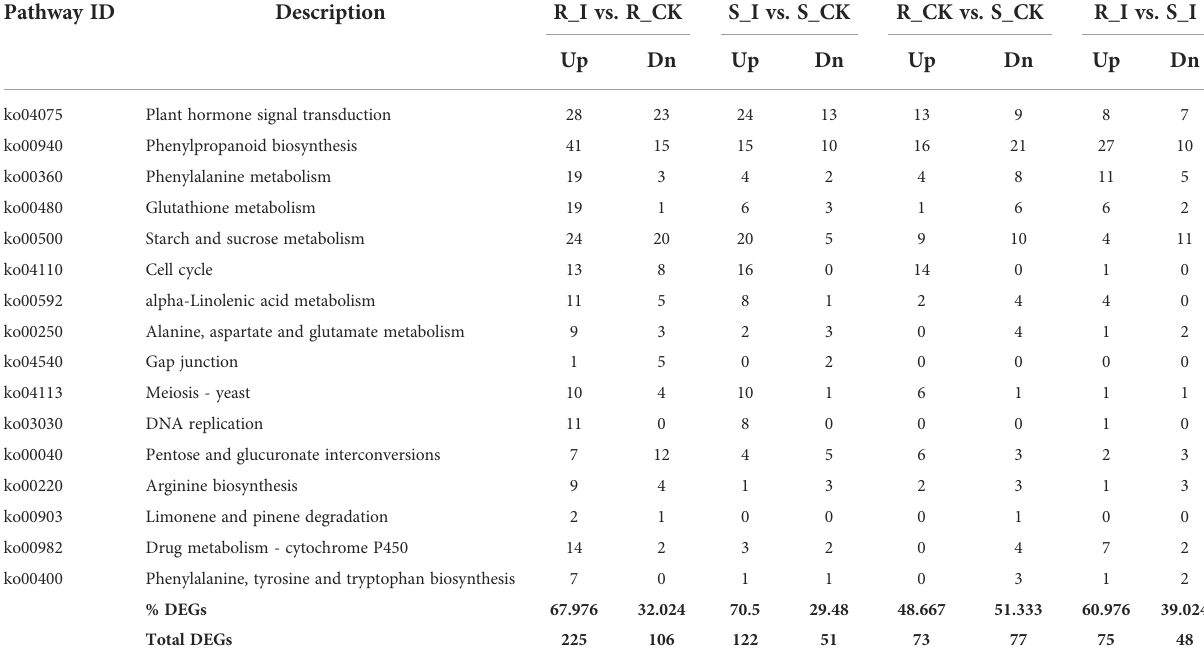
TABLE 1 List of top KEGG pathways associated with DEGs in various groups and number of up and downregulated genes in various comparison groups. Pathway ID